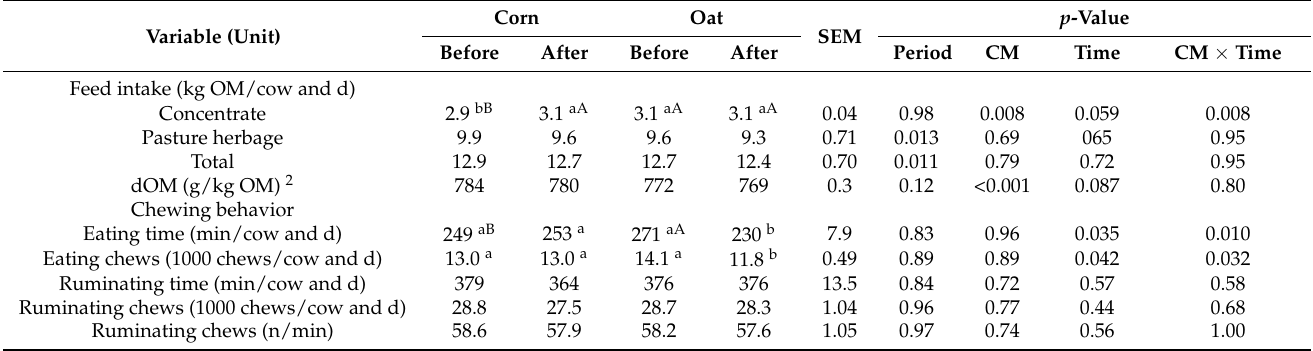
Table 3. Feed intake, diet digestibility, and chewing behavior of lactating Brown Swiss cows grazing a mixed alfalfa-ryegrass sward and supplemented with a corn- or an oat-based concentrate mixture before or after grazing (least-squares means, standard errors of means (SEM); n = 18 1